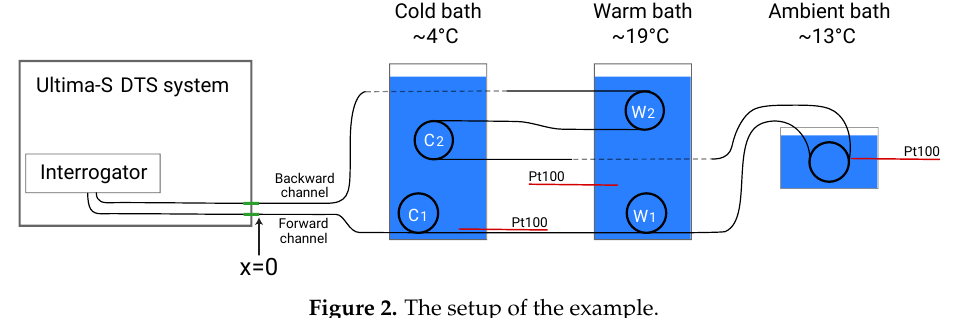
Figure 2. The setup of the example. Table 1. Fiber sections submerged in water